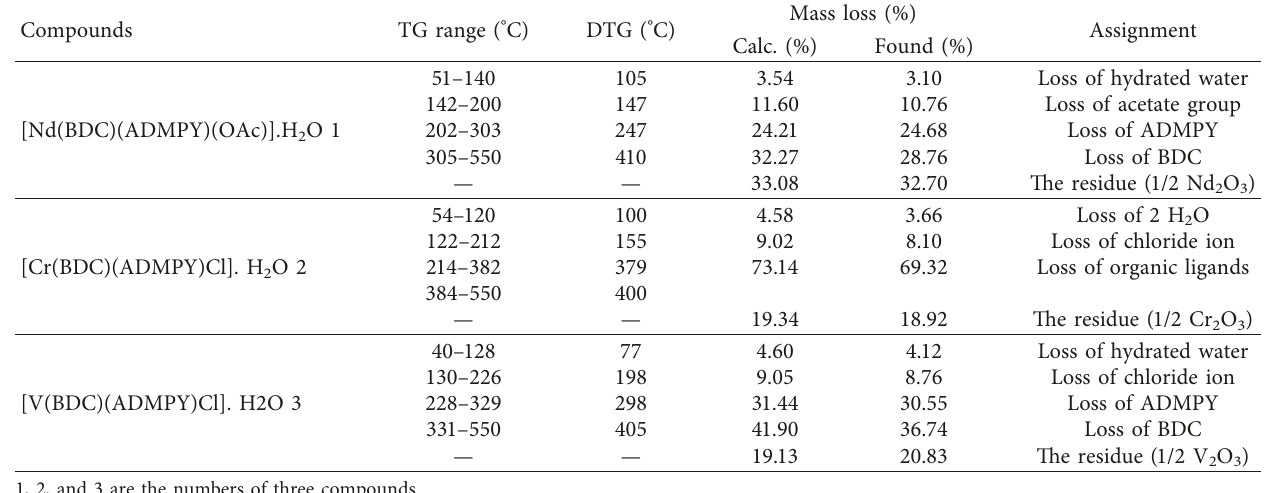
Table 5: Thermal analysis of metal compounds.